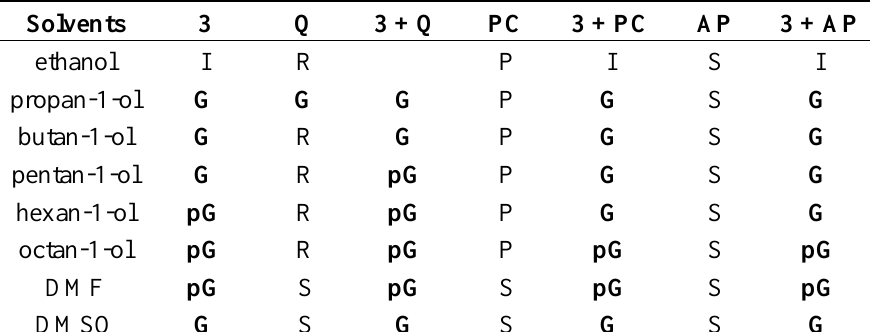
Table 2. Gelation tests (2% w/v).